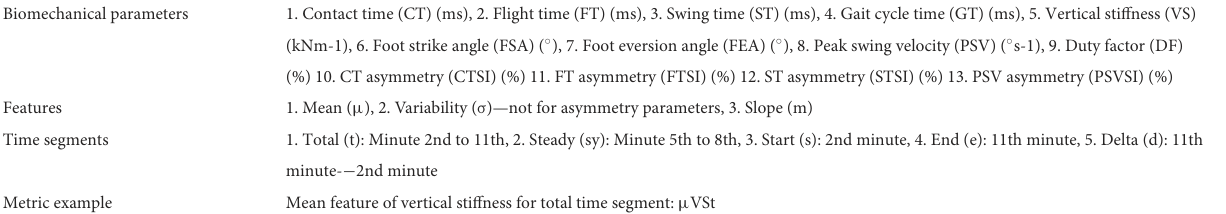
TABLE 1 List of biomechanical parameters (units) extracted using the data from foot IMU sensors, the features computed on these parameters, and the time segments over which they are computed. Biomechanical